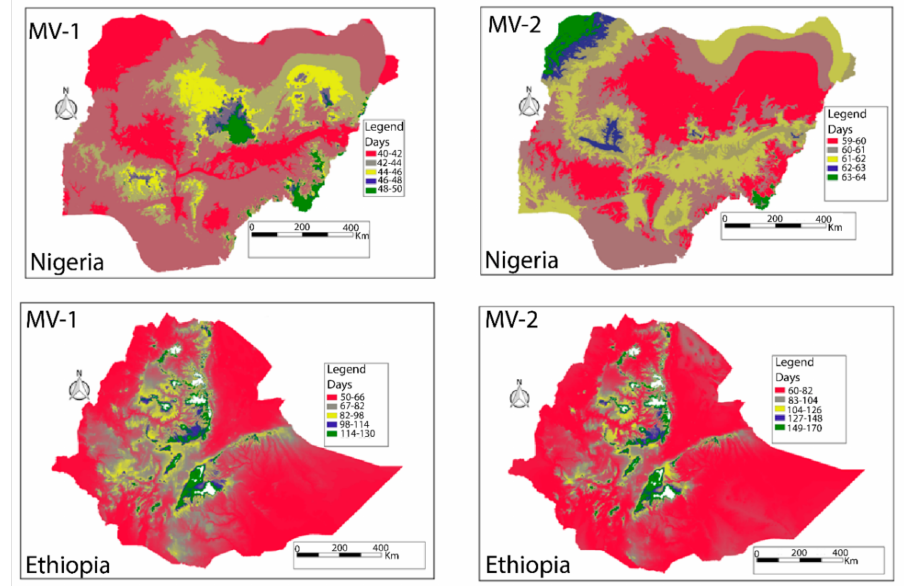
Figure 8. Maps of Nigeria and Ethiopia showing the number of days for two maize varieties (MV-1 and MV-2) would take during each phase (vegetative or reproductive) of development in di ff erent agro-ecologies. The small white dots are areas with missing values of